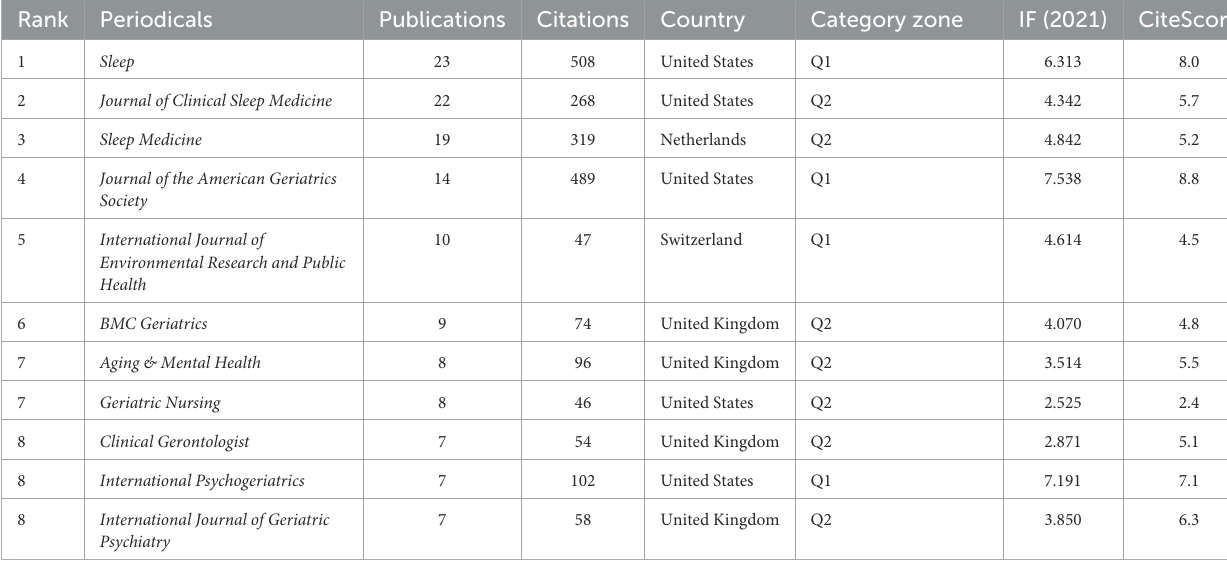
TABLE 1 Top 10 journals by